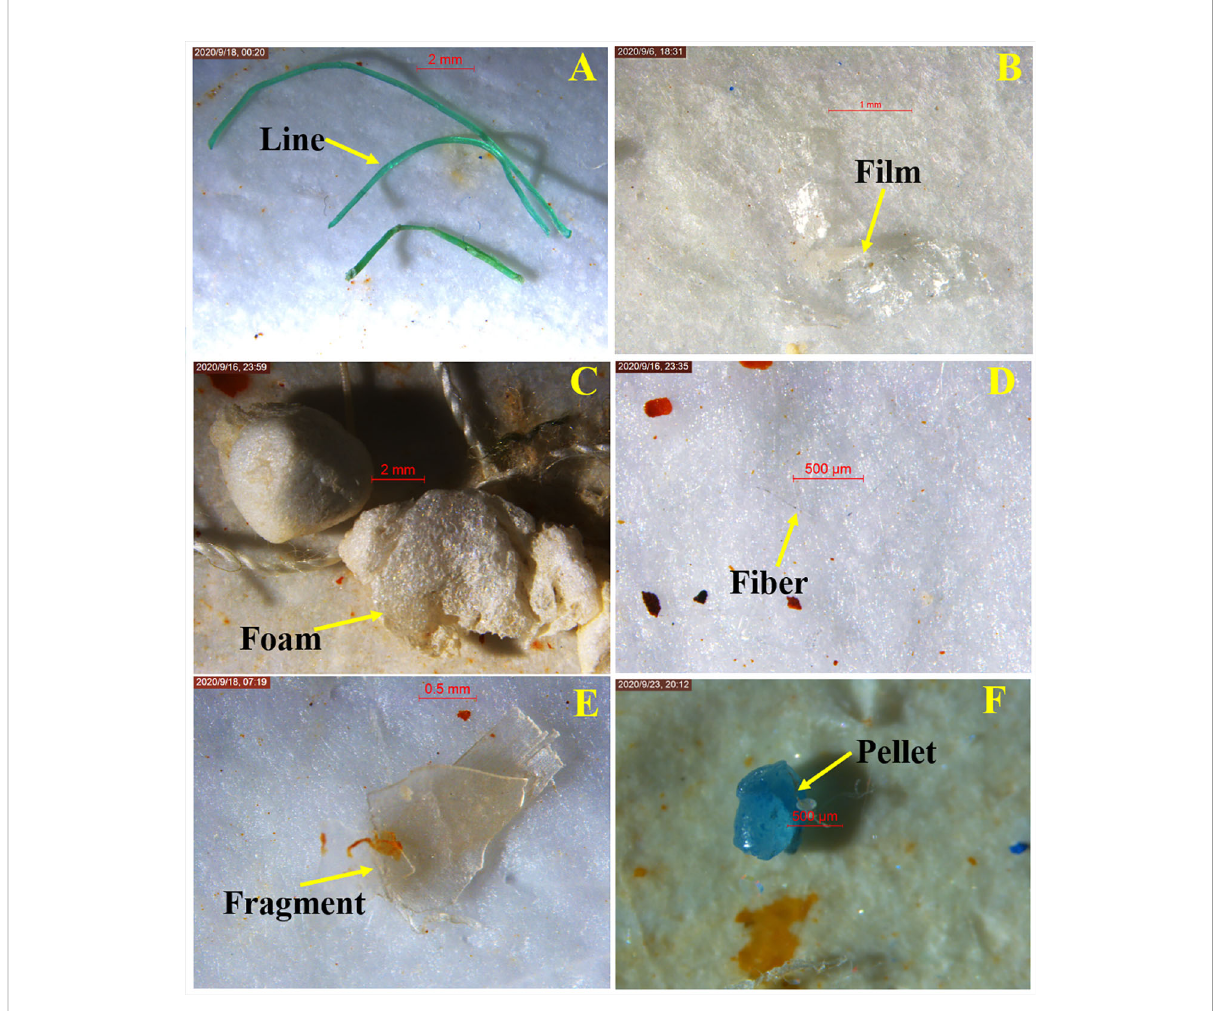
FIGURE 6 Microscopic images of representative MPs of different shapes collected from the surface seawater. (A) Line; (B) Film; (C) Foam; (D) Fiber; (E) Fragment; (F)